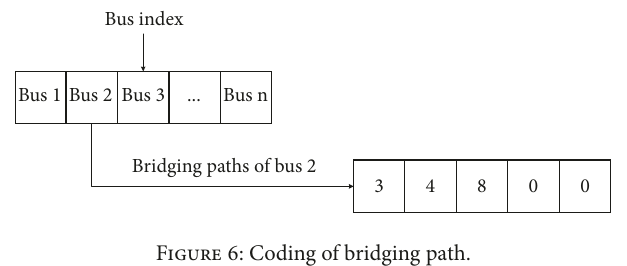
Figure 6: Coding of bridging